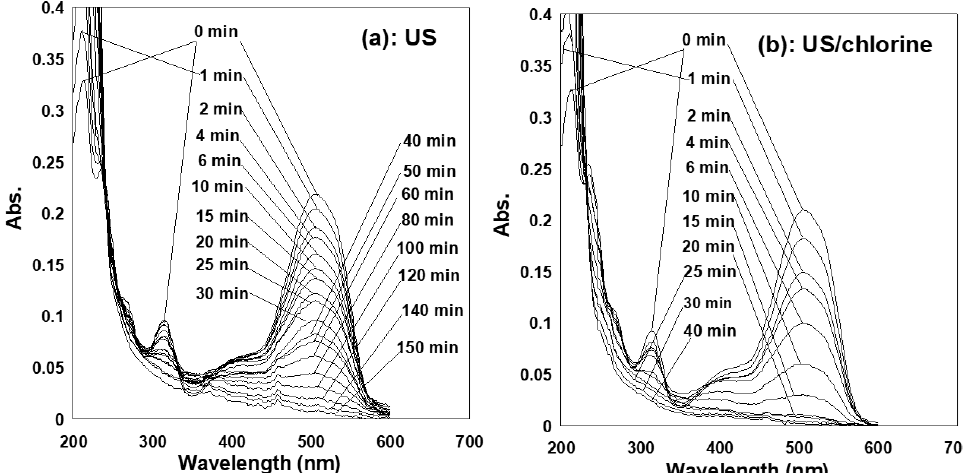
Figure 3. Changes in UV-Vis spectrums during the treatment of ARAC via ultrasound (US) ( a ) and US/chlorine ( b ) processes (conditions: C 0 = 5 mg·L −1 (10 µM), [chlorine] 0 = 250 µM, V = 150 mL, pH 5.5, temperature: 25 ± 1 °C, frequency: 600 kHz, power: 120 W).